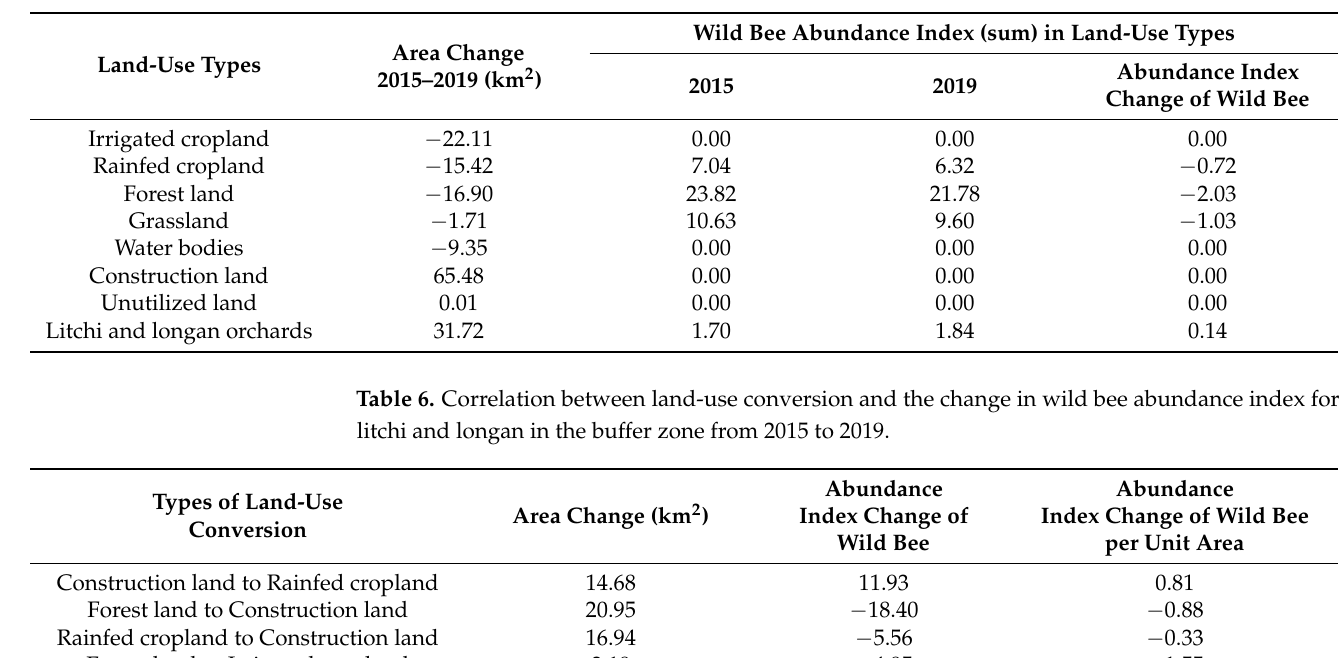
Table 5. Land-use types and wild bee abundance index for litchi and longan in the buffer zone of